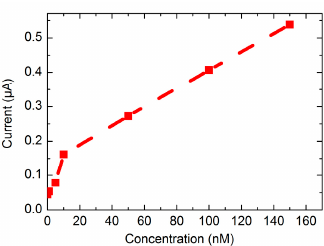
Figure 3. Calibration curve of adrenaline biosensor in the concentration range of 1 nM–150